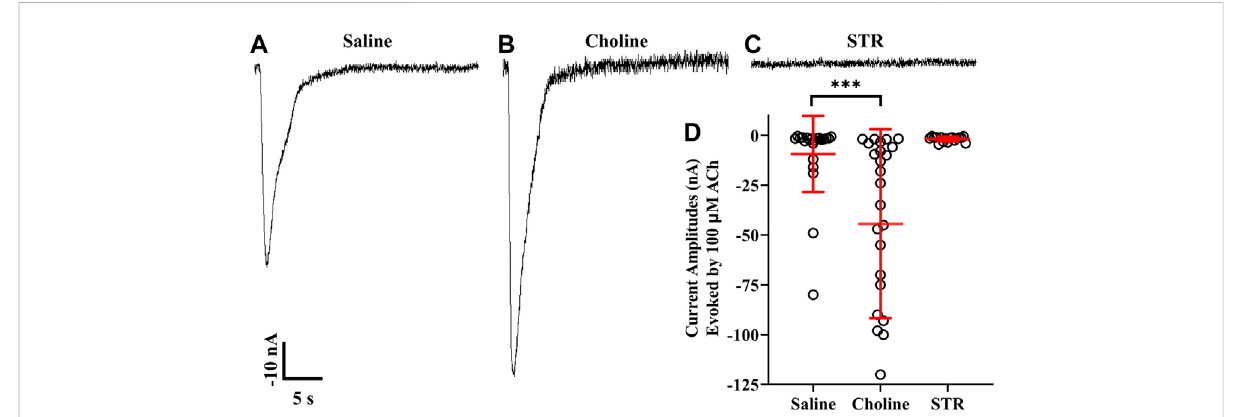
FIGURE 6 Choline enhances whereas STR inhibits functionality of human α 9 nAChRs expressed in X. laevis oocytes. Oocytes were injected with cRNA encoding human α 9 subunits and incubated for 3 days in frog saline or saline containing choline (5 mM) or STR (20 μ M) and assessed by voltage- clamp electrophysiology for functional responses to acetylcholine (ACh; 100 μ M). (A) A single 30 s current trace from a control oocyte incubated in frogsaline.TheoocytesrespondedtoAChwithcurrentamplitudesthatwere − 9±19 nA(n=22). (B) Currentamplitudesrecordedfromoocytes incubated withcholinewere − 44± 47 nA(n= 25);asubsetofthisgroupofoocyteswasincubatedinfrogsalinecontainingSTR(20 μ M)for24 hand reassessed for functional responses. The current amplitudes after exposure to STR were reduced to − 2.1 ± 1.2 nA compared to − 78 ± 44 nA (n = 5). (C) Similarly,oocytesincubatedwithSTRfor3 dayshadAChresponsesof − 1.8±1.2 nA(n=17). (D) Scatterplotofthedatafortheexperimentsshown in (A – C) . Current amplitudes from oocytes incubated with choline were signi fi cantly larger compared to saline controls. The current amplitude and duration scale-bars apply to all traces. The “ ± ” and the error bars in (D) indicate SD. The “ n ” indicates the number of oocytes obtained from three